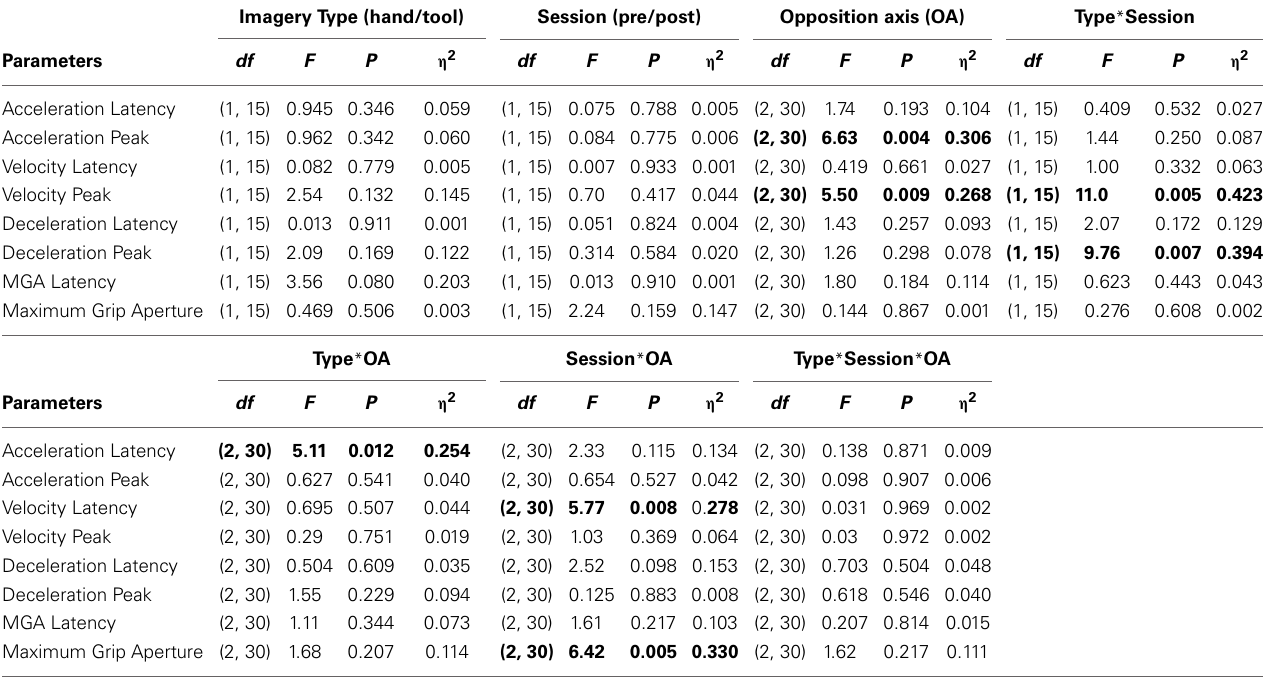
Table 1 | Main effects and interactions observed for the ANOVA performed on each kinematic parameter.